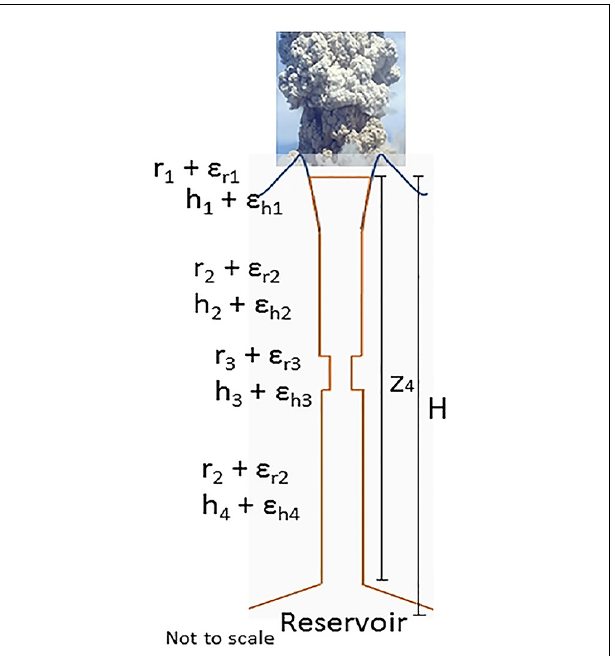
FIGURE 2 | Schematic model conduit geometry for Soufriere Hills volcano (after Thomas et al., 2018; see text); conduit radii and lengths are denoted by r n and h n , with related uncertainties ε n . Dimensions z 4 and H refer to nodes on Figure 3 and represent BBN random variables: overall conduit length and depth to effective level of the magma reservoir, respectively. z 4 is the sum of random variables h 1 + h 2 + h 3 + h 4 ; H is modeled equal to or greater than z 4 to allow for the possibility of a small reservoir cap sealing eruptible reservoir magma from the conduit